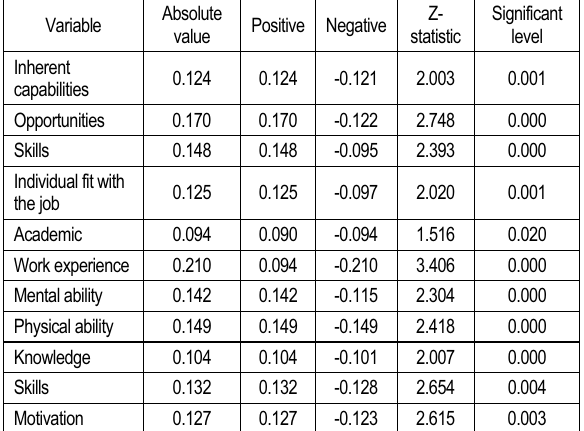
Table 2. Normality test results for variables